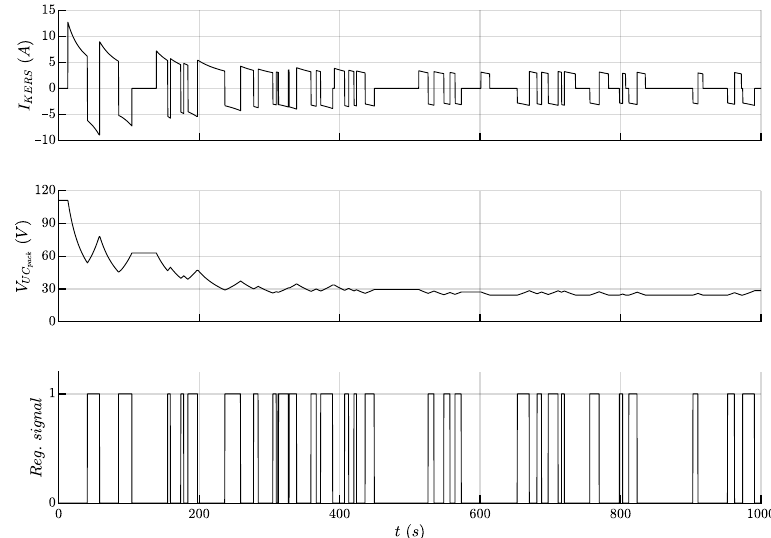
Figure 6. KERS current, resulting UC voltage, and regeneration brake control signal (Reg.